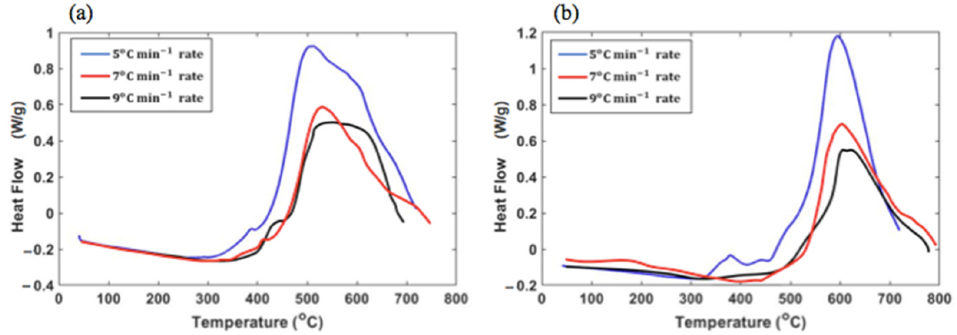
Figure 6. DSC results at different heating rates for ( a ) SWCNT and ( b ) MWCNT .